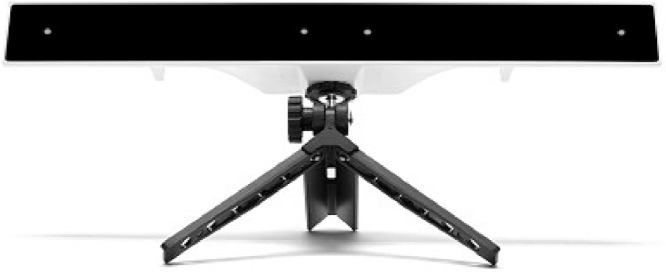
Eye-tracker. Gazepoint GP3 eye-tracker used in the experiment [6].